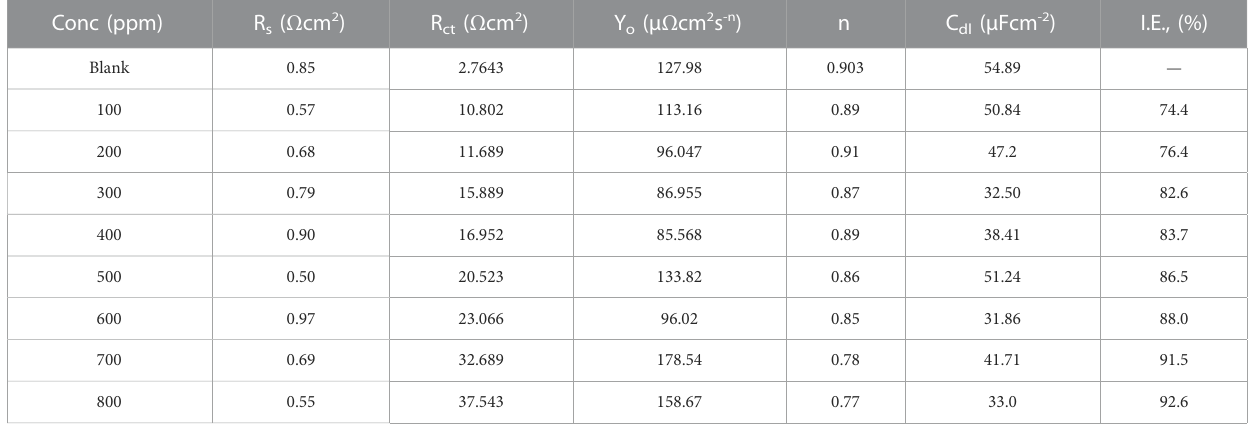
TABLE 2 Electrochemical Impedance spectroscopy corrosion parameters for mild steel in 1M HCl with polyacrylamide graft of okra at 25 ° C. Conc